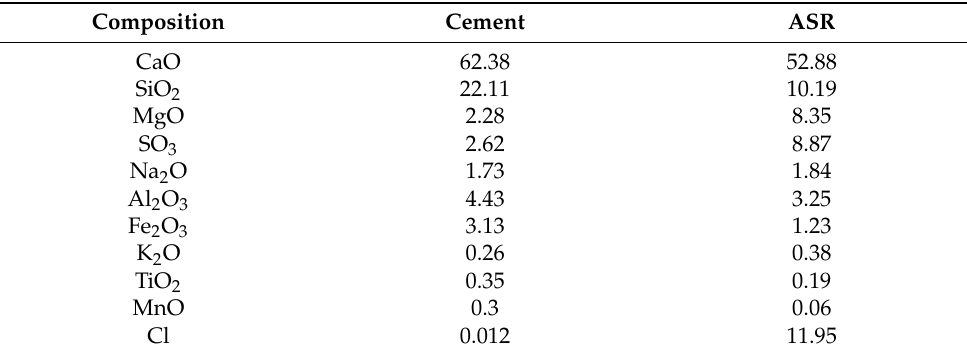
Table 1. Chemical composition of raw materials (mass